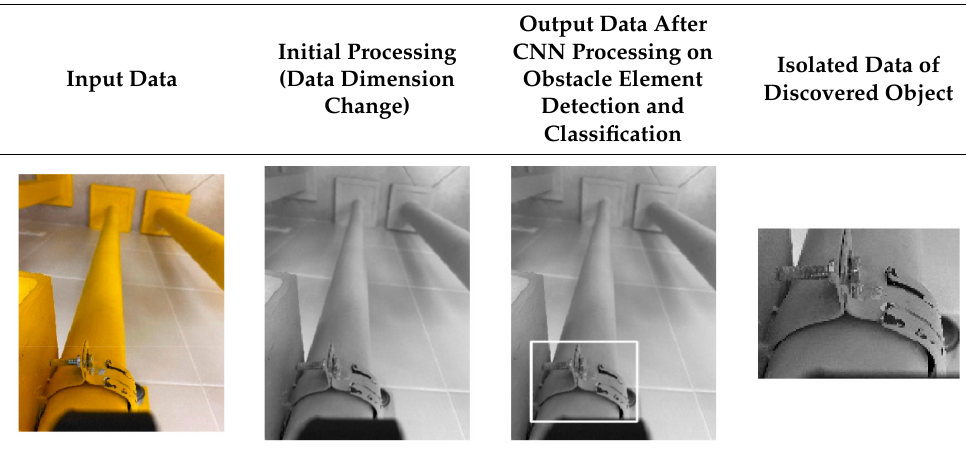
Table 8 details the process of input processing, classification, and detection of pipeline constructive elements, which is a visualization of row 2 in Table 7. Table 8. Step-by-step visualization of the obstacle classification process. Copyrighted by authors.